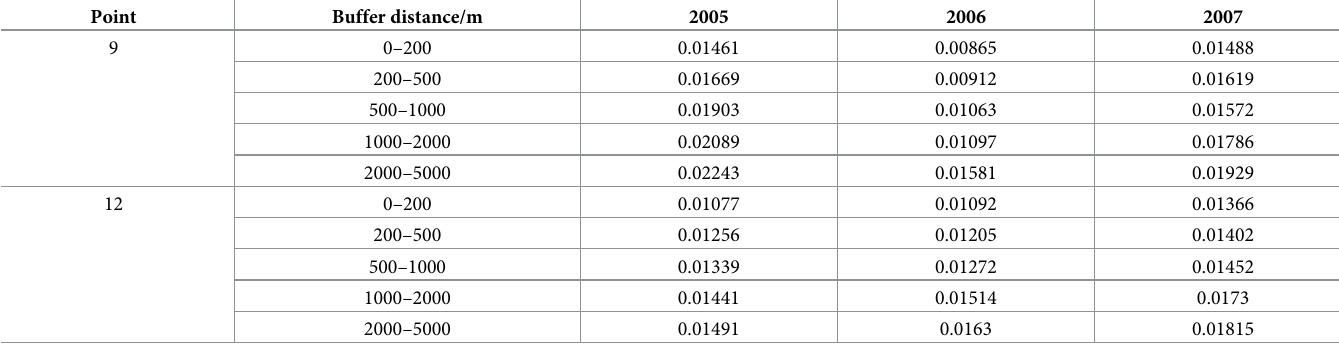
Table 6. Annual average VSWI within the radius of each interchange node of Dongyong Expressway before and after its construction. Point